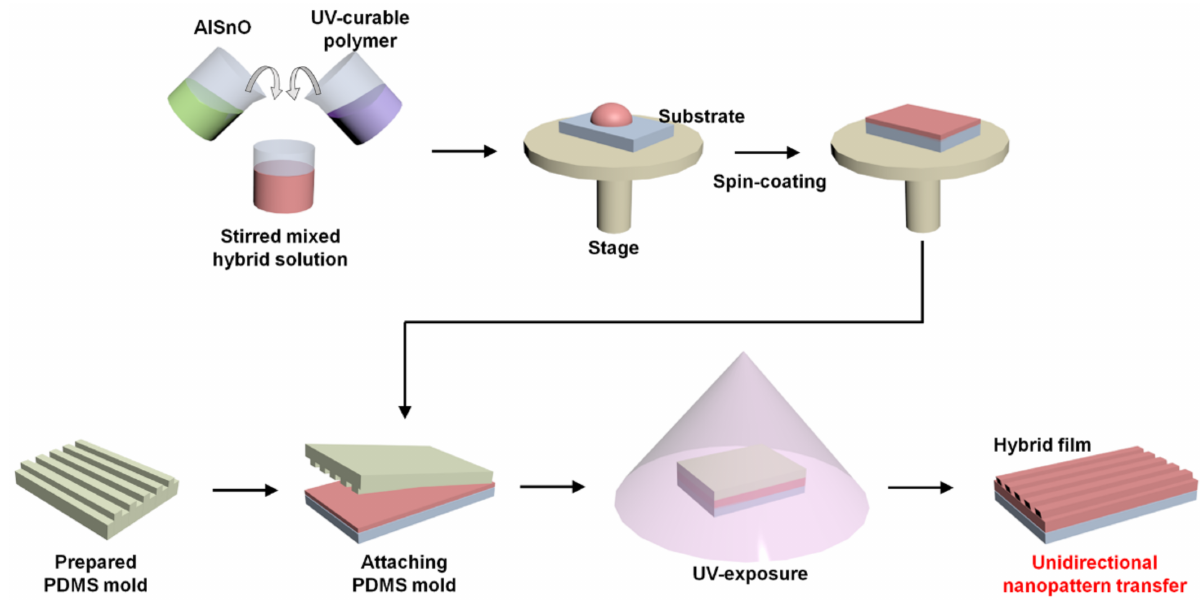
Figure 2. Schematic of the unidirectional nanostructure shifting process from PDMS mold to UV- curable polymer/AlSnO hybrid film surface by UV-NIL